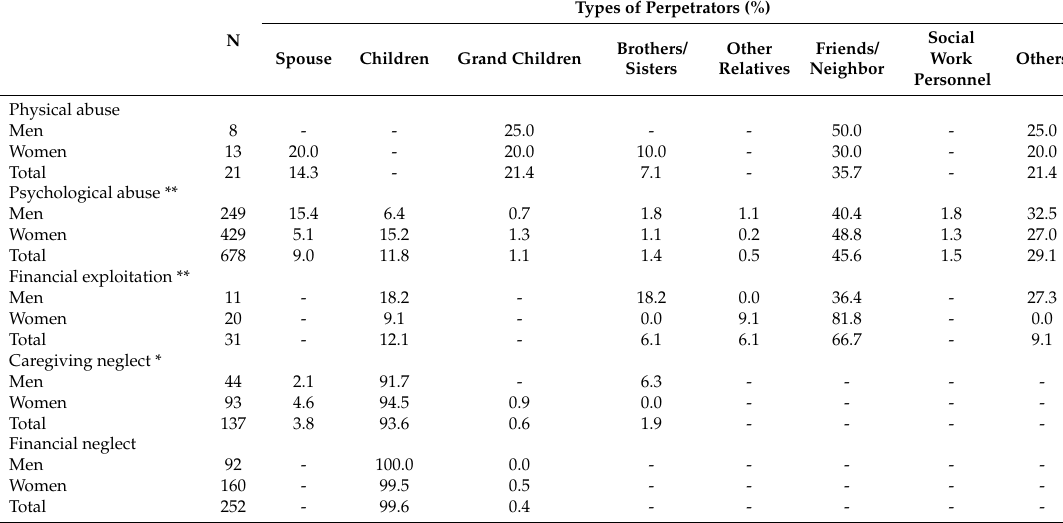
Table 3. Distribution of Perpetrators of elder abuse among community-dwelling men and women aged 65 years or over.